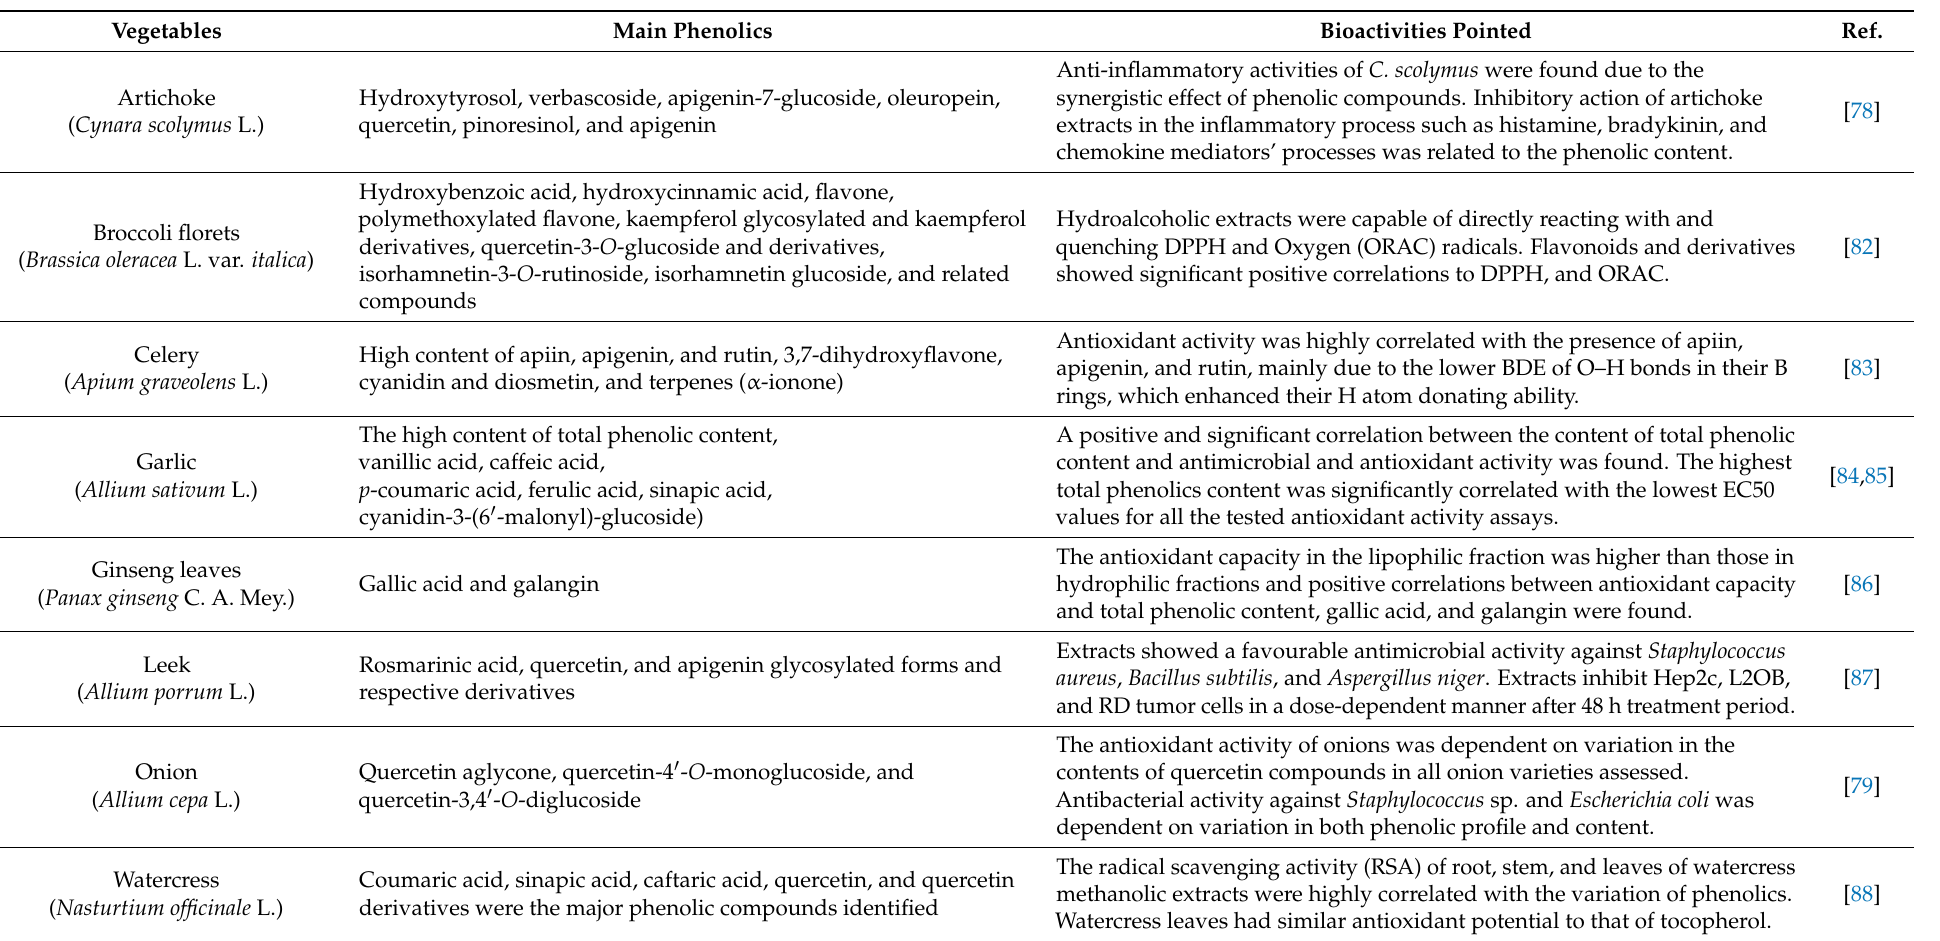
Table 2. Phenolic compounds present in some vegetables consumed worldwide and the main bioactivities